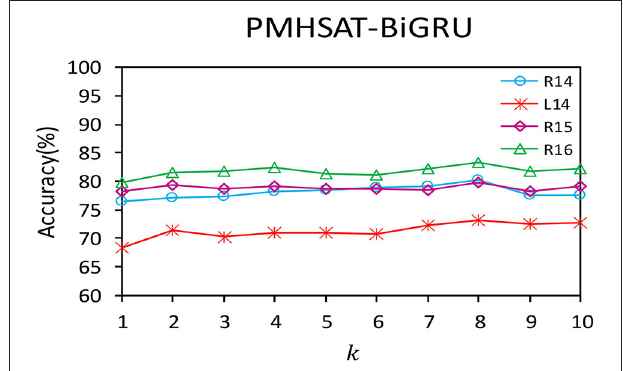
72.80 - - PMHSAT-BiGRU 80.27 69.25 The bold value indicates that the effect of this method is the best compared with other baseline models.